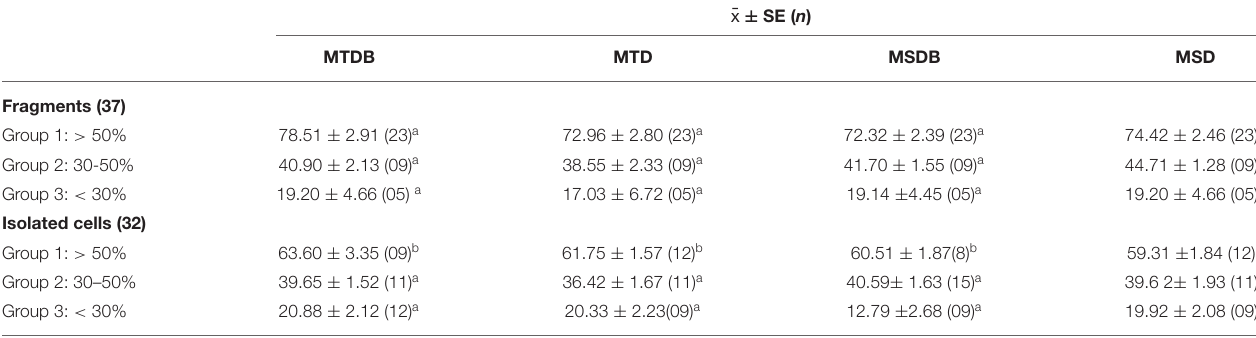
TABLE 2 | Mean Percentage of cell Viability calculated by Trypan blue exclusion